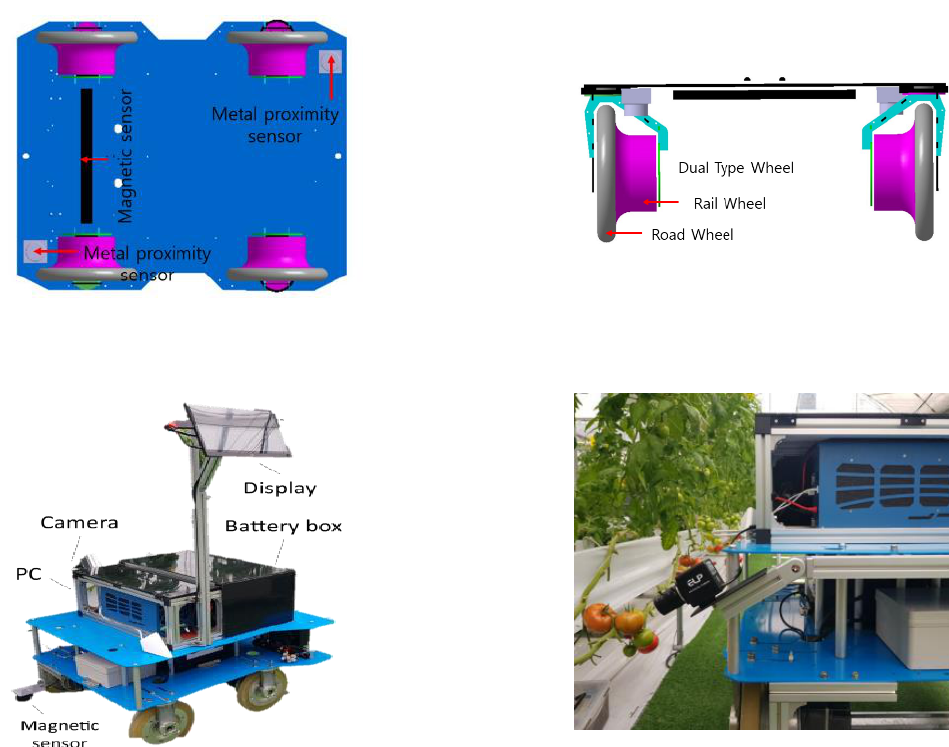
Figure 1. The general hydroponic greenhouse in Korea.